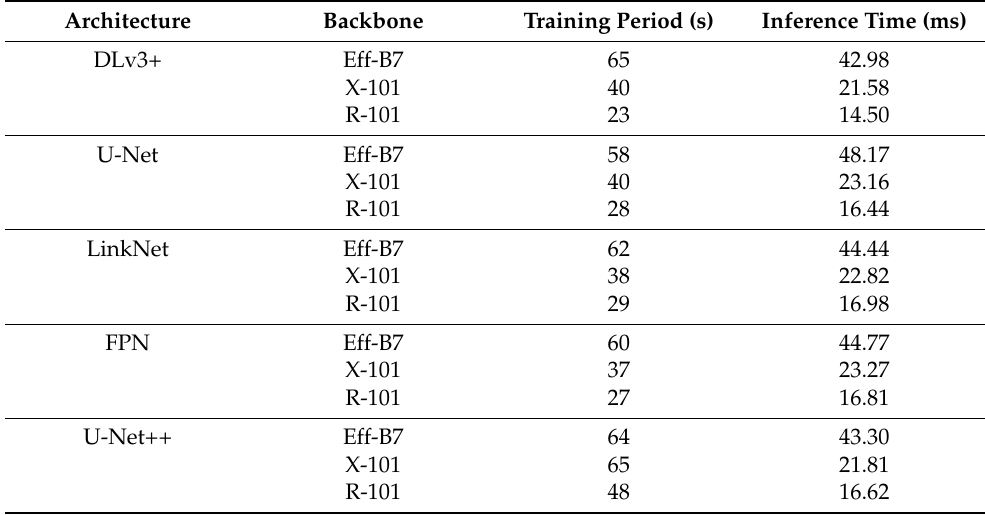
Table 4. Training period (in seconds), and inference time (in milliseconds) considering a computer equipped with an NVIDIA RTX 3090 (24 GB RAM) with an i9 processor for the DeepLabv3+ (DLv3+), U-Net, LinkNet, Feature Pyramid Newtork (FPN), and U-Net++ architectures and the Efficient-net-B7 (Eff-B7), ResNeXt-101 (X-101), and ResNet-101 (R-101) backbones. Architecture